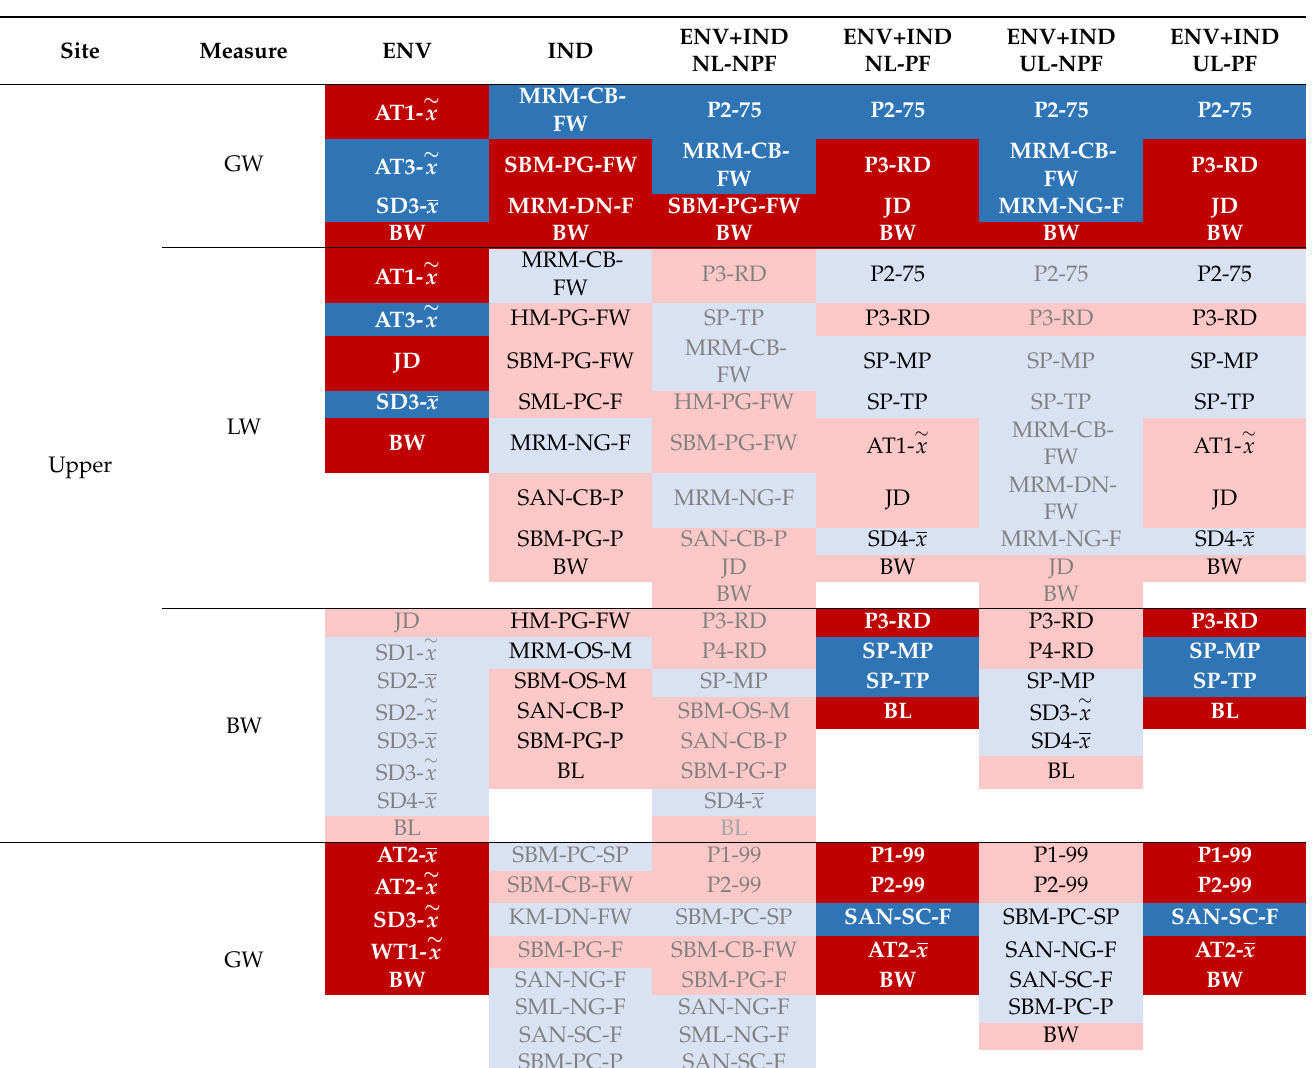
Table 1. Environmental and industrial covariates selected by EN for gonad weight (GW), liver wight (LW), and body weight (BW) of female fish captured at the Upper and Lower Ells locations; NL = no limits; UL = upper limits; NPF = no penalty factors; PF = penalty factors; bolded white text with saturated fill color in cells comprise best-fit judged by AIC values; red = positive coefficients; blue = negative coefficients; marginal models indicated as unsaturated fill and black